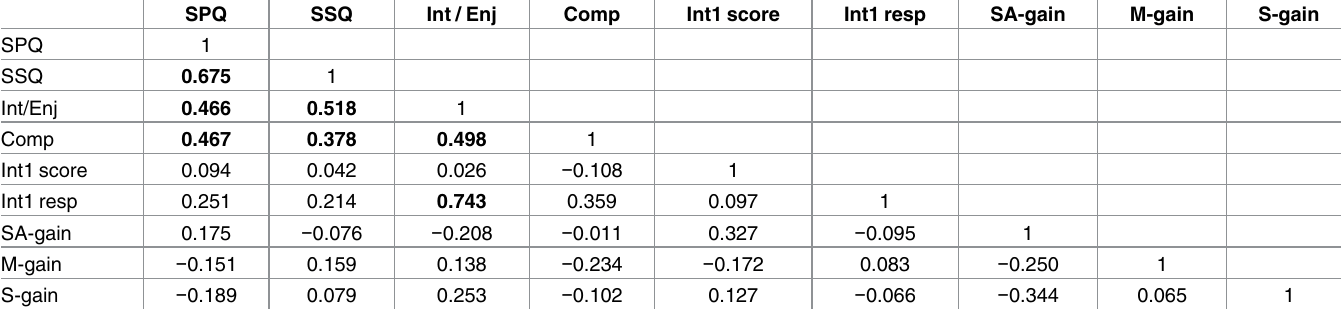
Table 4. P-condition correlations. Pearson product-moment correlationcoefficientsfor the P conditionbetweenthe post-experiment questionnaires, first interaction score and response, and the overalllearninggain. Cells in bold denotecorrelationssignificantat least at the .05 level. SPQ SSQ Int / Enj Comp Int1 score Int1 resp SA-gain